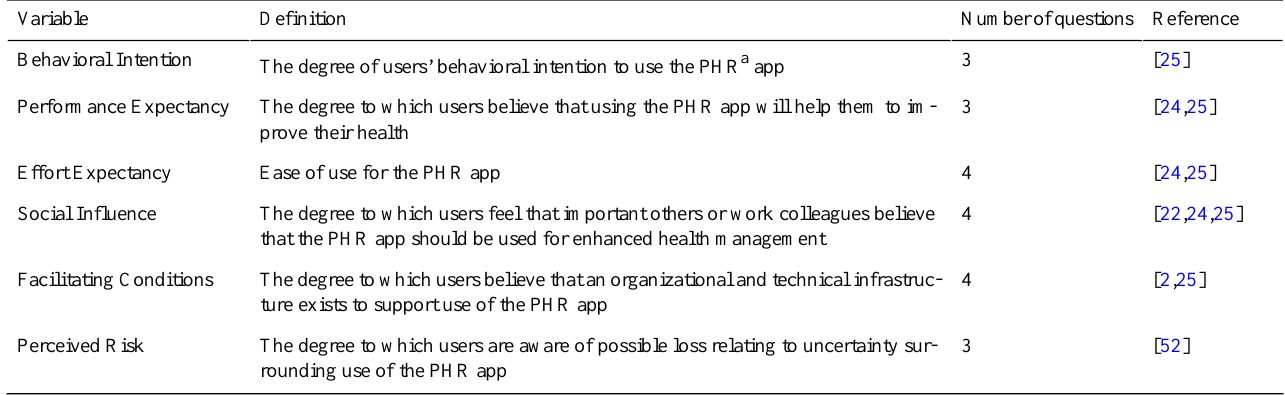
Table 1. Definition of